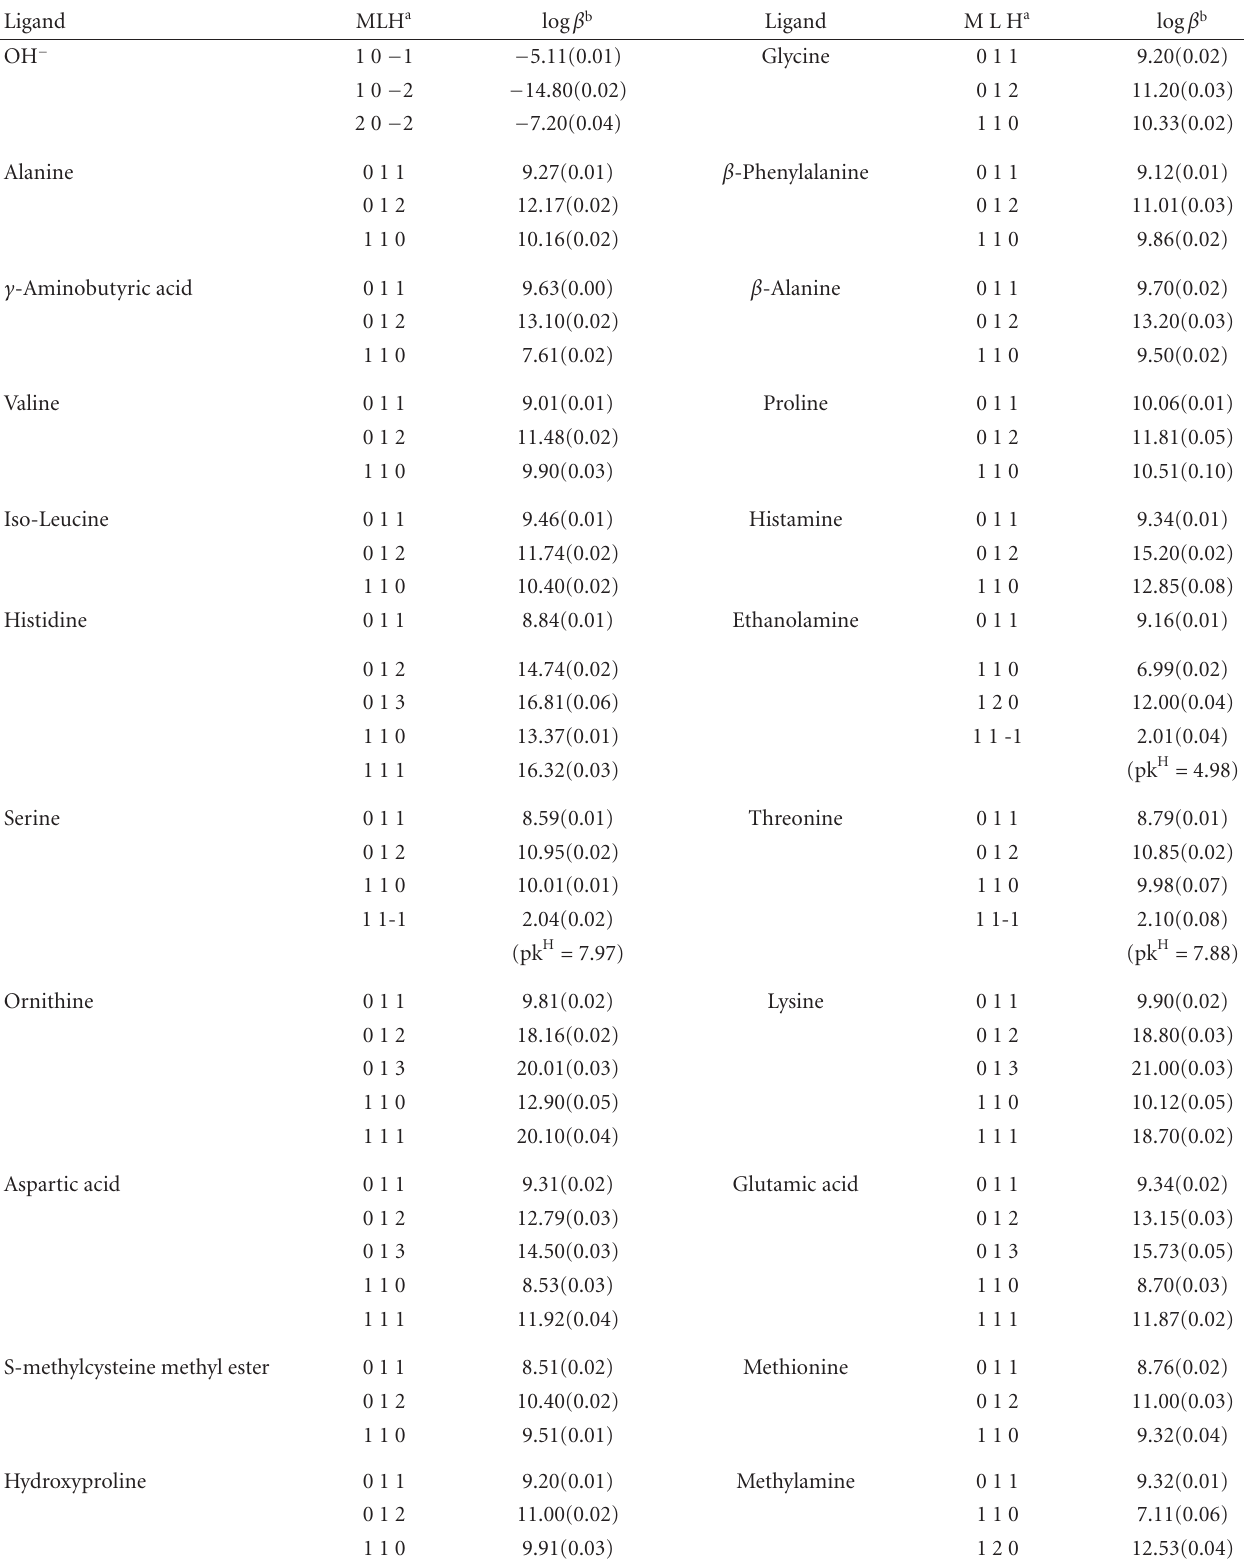
Table 1: Formation constants for complexes of [Pd(DEEN)(H 2 O) 2 ] 2+ with amino acids at 37 ◦ C and 0.16 M ionic